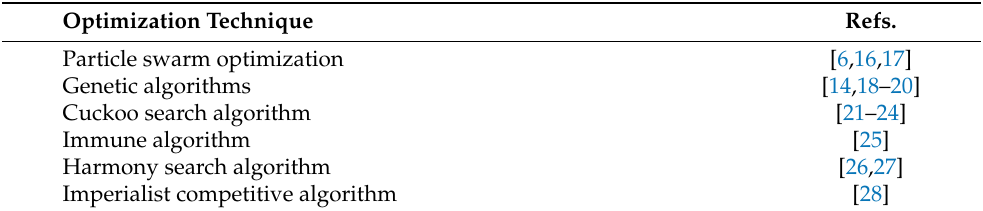
Table 1. Meta-heuristic approaches applied to the optimal location and sizing of D-STATCOMs in electric distribution